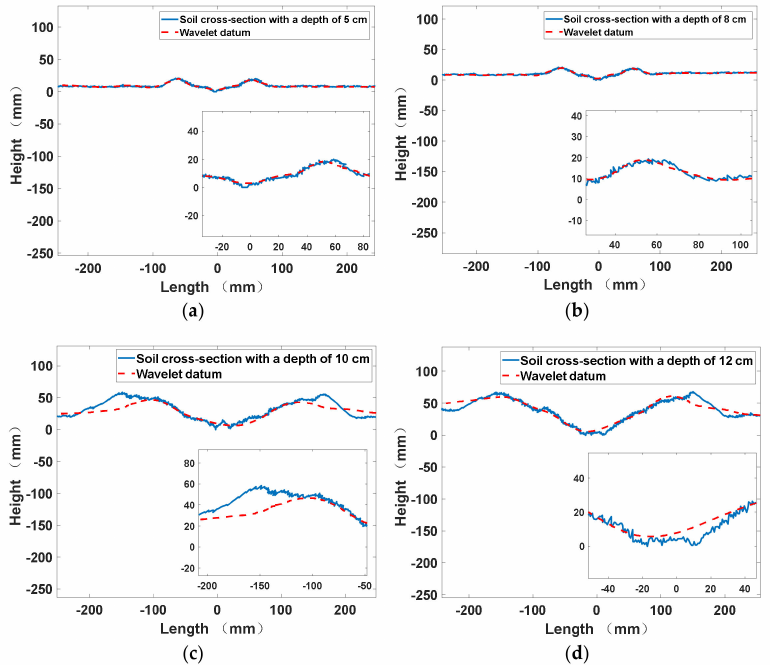
Figure 9. Cross-sections of digital model and wavelet datum surface under different ditching depths. ( a ) Ditching depth of 5 cm. ( b ) Ditching depth of 8 cm. ( c ) Ditching depth of 10 cm. ( d ) Ditching depth of 12 cm.